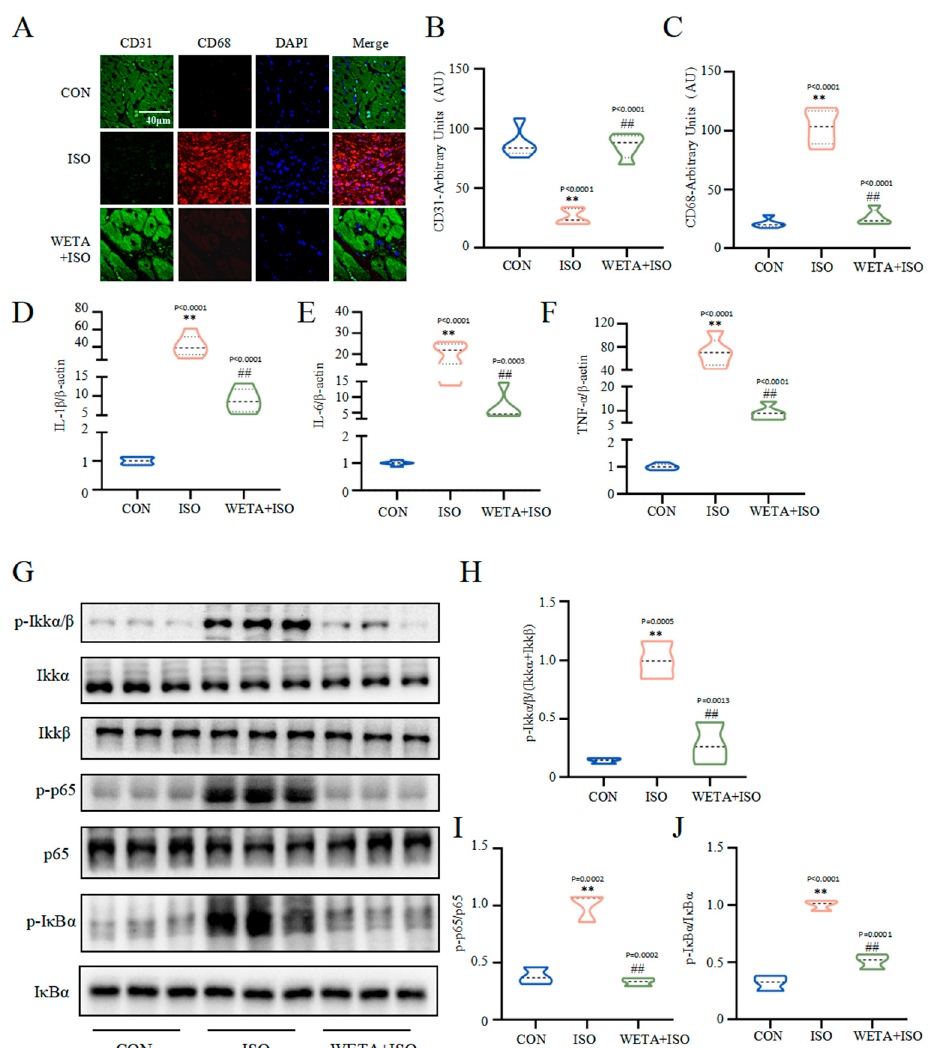
Figure 6. WETA attenuated the inflammatory response in heart tissues of ISO-induced rats. ( A ) Immunofluorescence staining images of CD68 (red), CD31 (green), and nuclei (blue) (scale bar = 40 μ m). Mean fluorescence intensity of CD68 ( B ) and CD31 ( C ); mRNA levels of IL-1 β ( D ), IL-6 ( E ), and TNF- α ( F ). ( G ) Western blot results of the levels of p-Ikk α / β (H), p-p65 ( I ), and p-I κ B α ( J ). Values are mean ± SD (n = 6), ** p < 0.01 vs. CON group; ## p < 0.01 vs. ISO group, using one-way ANOVA.